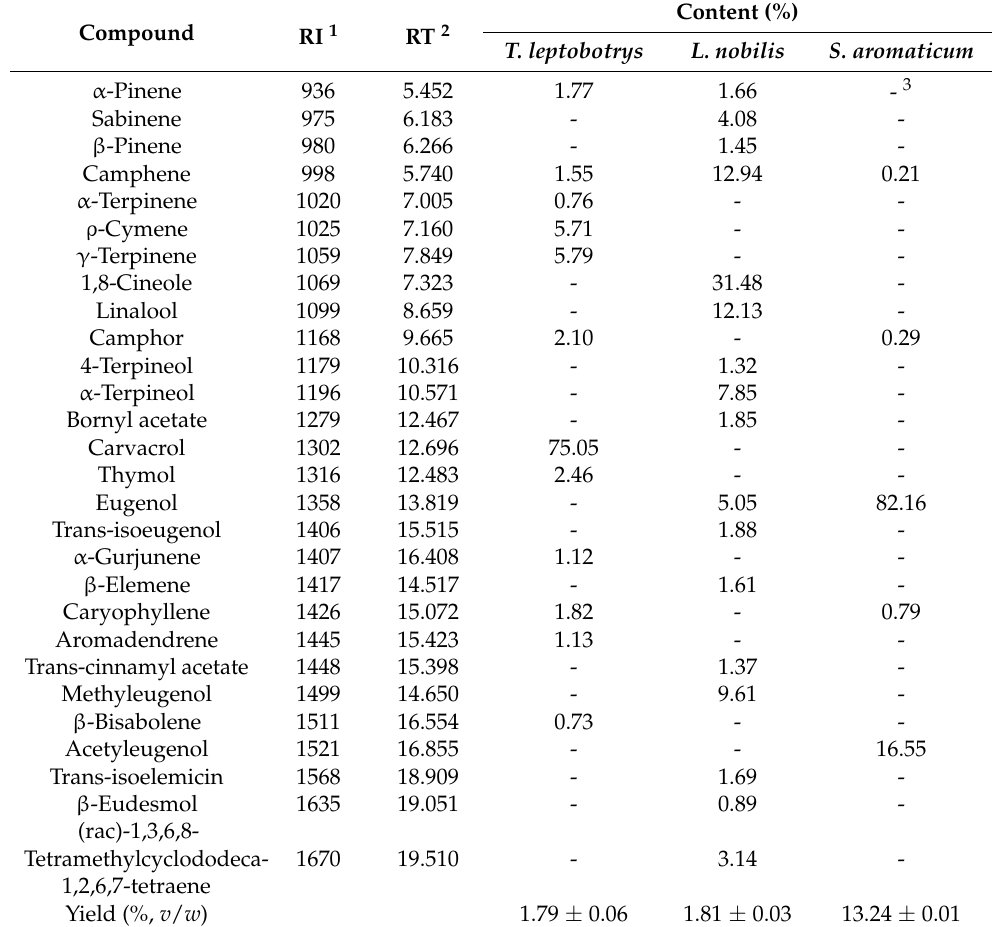
Table 1. Yield and composition of essential